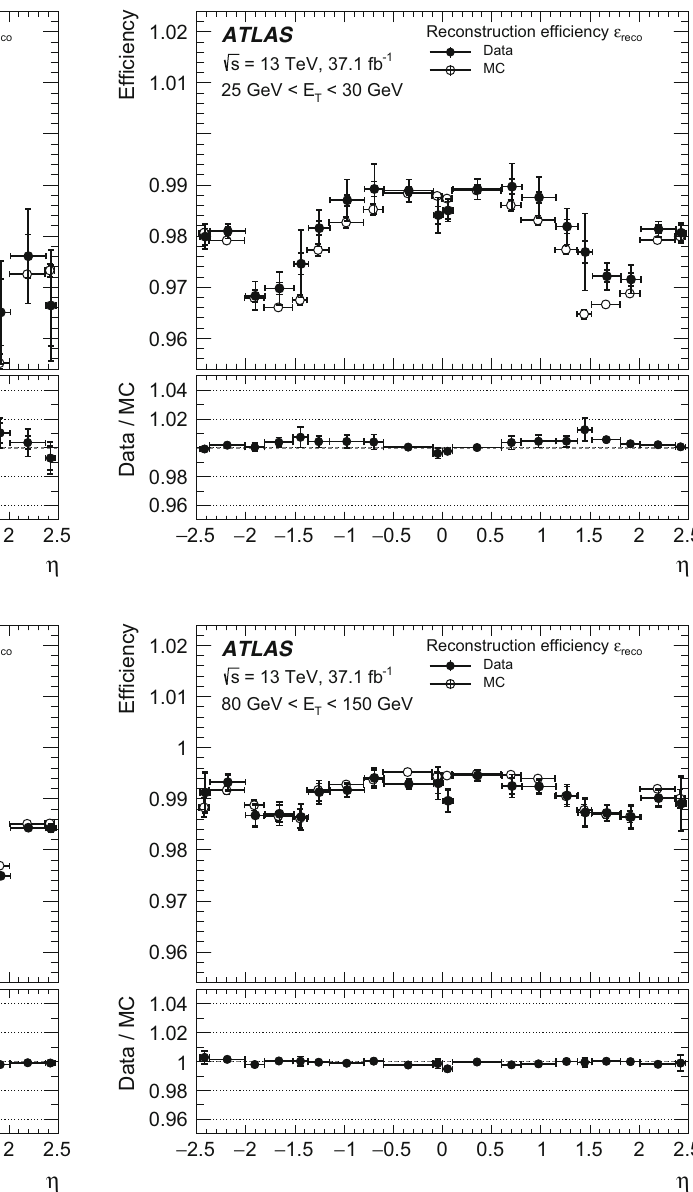
30 GeV (top right), 40–45 GeV (bottom left), and 80–150 GeV (bottom right). The inner uncertaintiesare statisticalwhilethe totaluncertainties include both the statistical and systematic